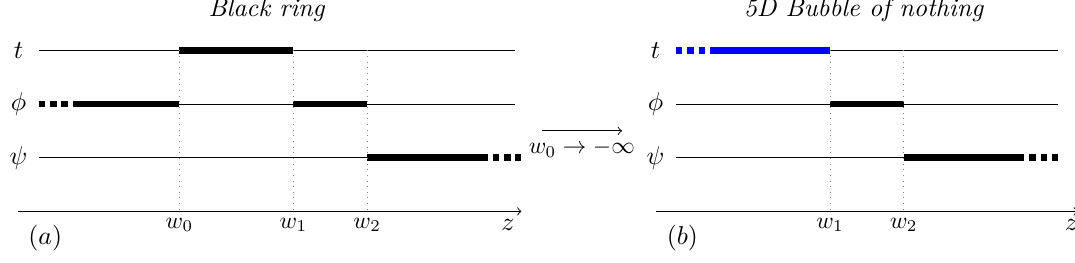
w w 0 → −∞ , with 1 and 2